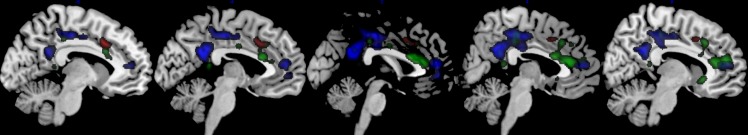
Task- and DZ-related BOLD responses in the cingulate cortex.The sagittal brain images show regions with task-related positive (red) and negative (blue) BOLD responses in the cingulate cortex in the whole group during the working memory task. Regions where the BOLD responses correlated inversely to diazepam plasma concentration are visualized in green. Task-negative and diazepam-attenuated responses were significant after family wise error (FWE) correction for multiple comparisons. Task-positive responses in the cingulate cortex were not significant after FWE correction.